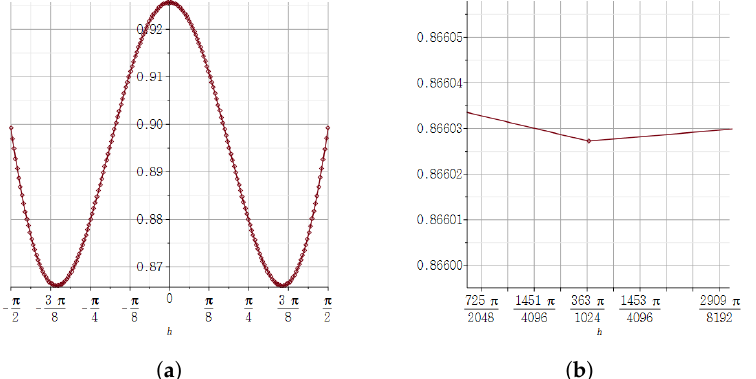
Figure 6. ( a ) The result of expressing the value of the relative error of the quaternion ( j , k ) -step derivative of e z at z 0 on the vertical axis according to the size of the horizontal axis h using the Maple plot. ( b ) In the graph of ( a ), the result of zooming in about h near 3 π relative error is to